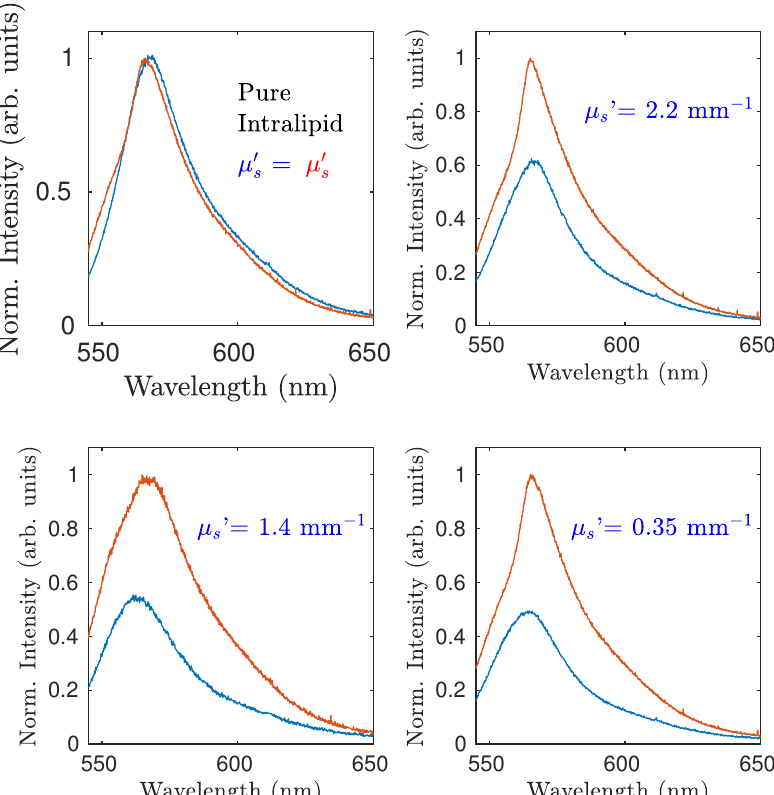
Figure 3. The red emission is for the sensor that always remains in contact with pure Intralipid, whereas the blue one pertains to different dilutions of Intralipid 20% (zero dilution for the top- left case).